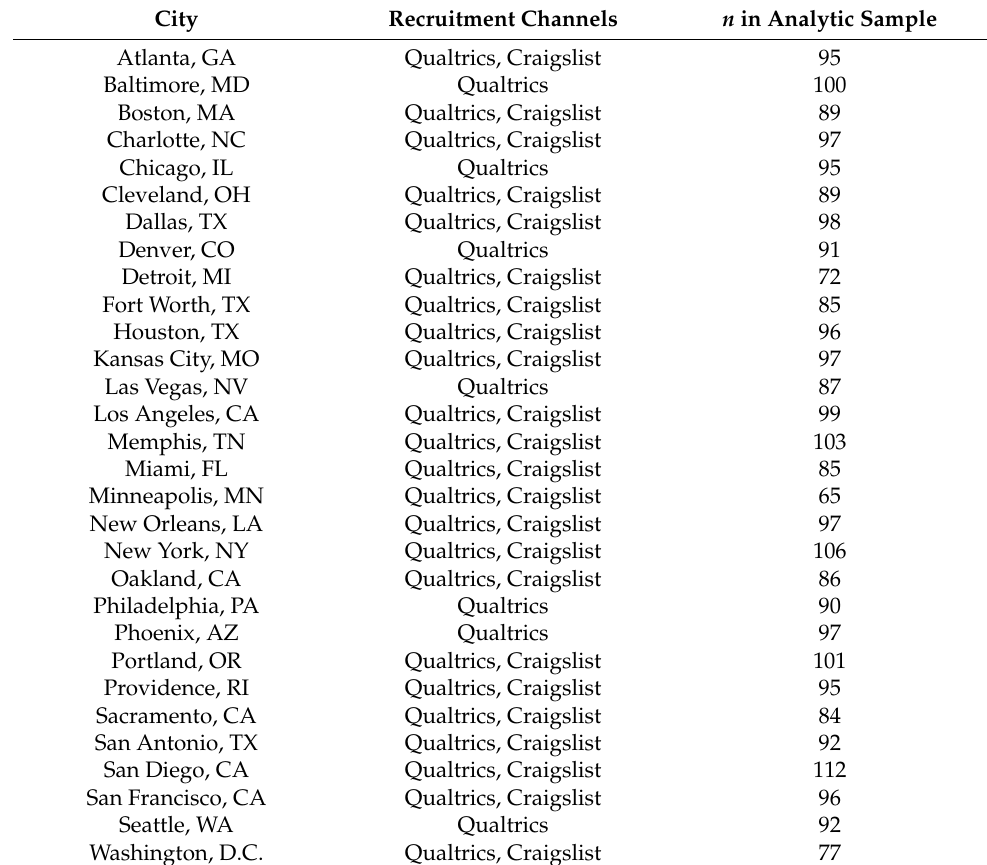
Table A1. Participants and recruitment channels in each of 30 U.S.